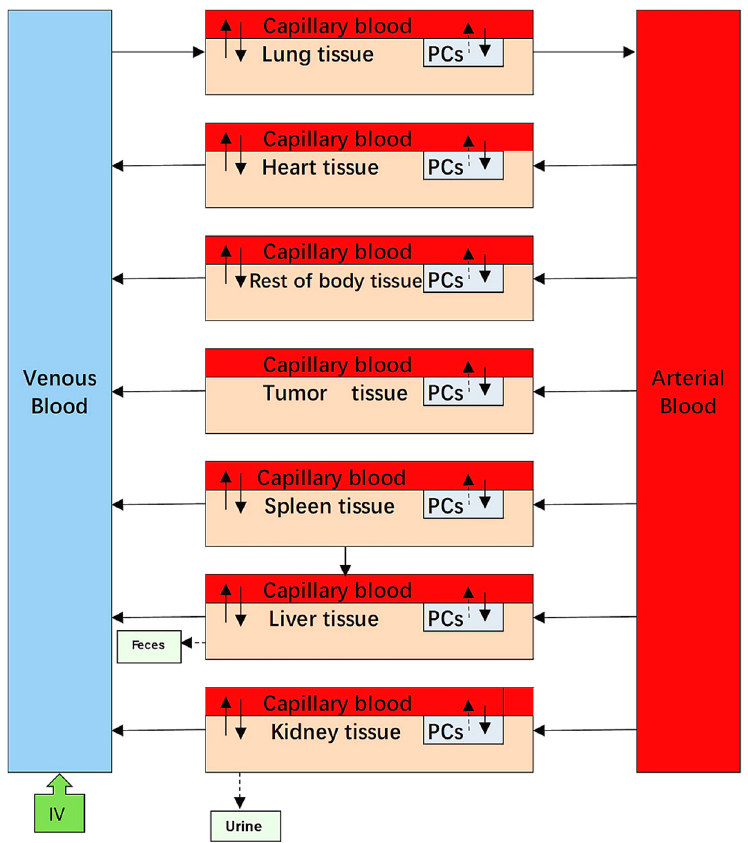
Figure 18. Structure of a blood flow-limited PBPK model for all the five mPEG-PCL NPs formula- tions, including phagocytosing sub-compartment in organs shortened as “PCs.” Arrows show the transportation of mPEG-PCL NPs while grey boxes indicate the uptake of mPEG-PCL NPs by PCs separated from blood circulation or tissues. Here the tissue represents interstitial space of organs when used to simulate our experimental data of mPEG-PCL NPs.